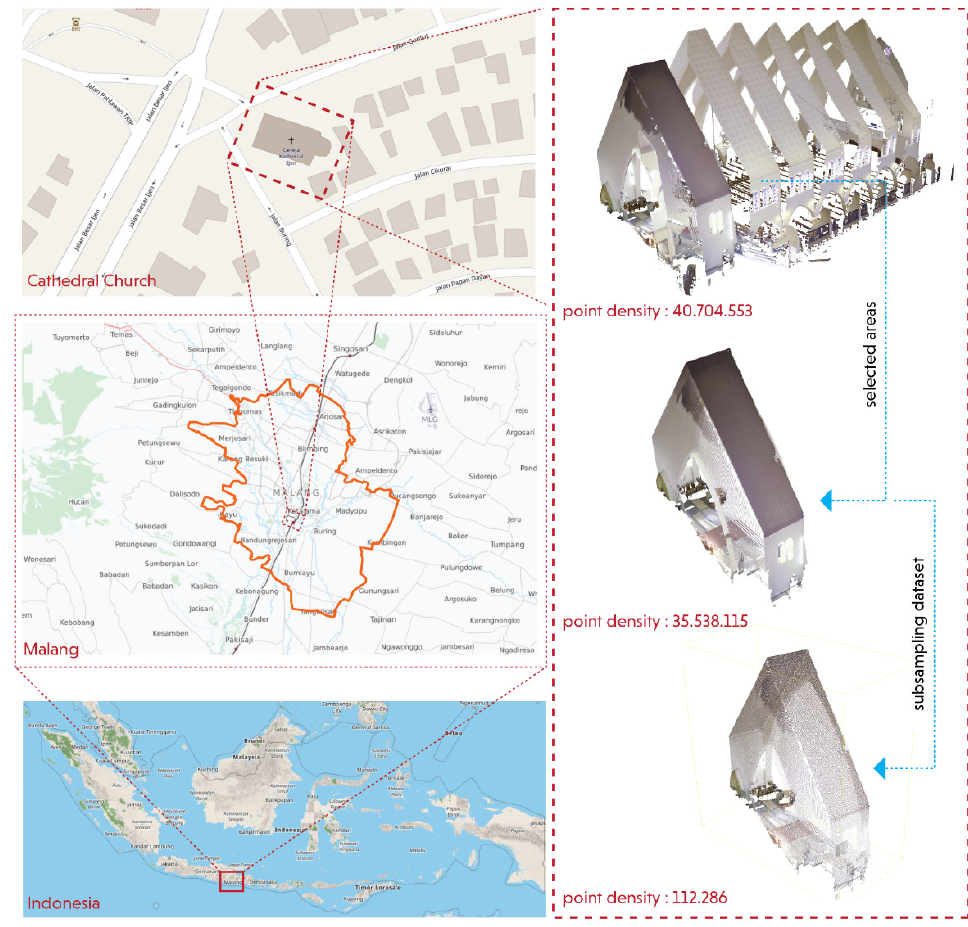
Figure 2. A selected dataset of Ijen Church (St. Virgin Mary of Mount Carmel).